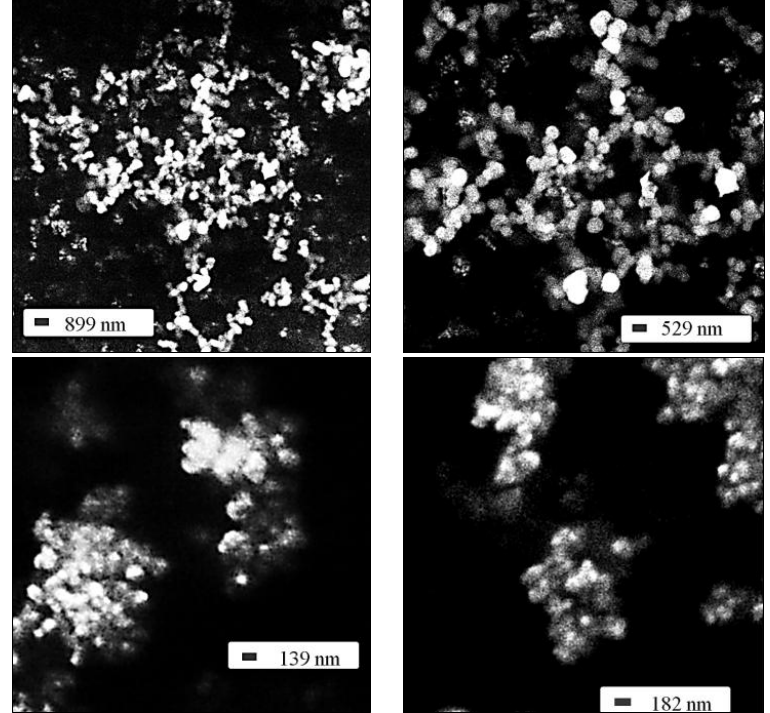
Figure 3. Scanning electron microscopy (SEM) images of Ba different amplifications.